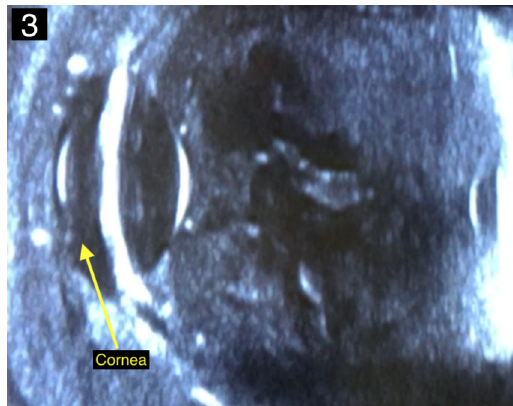
Figure 3: Ultrasound image of the right eye demonstrating dense hyperechoic cellular debris within the vitreous cavity suggestive of